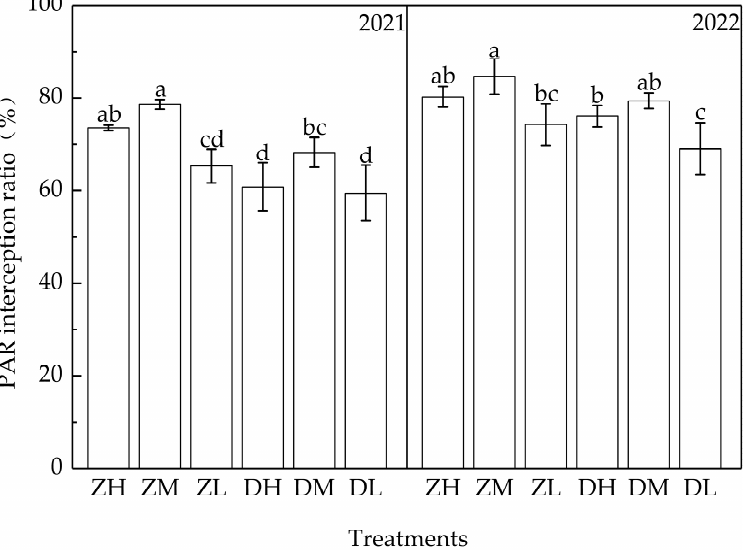
Figure 3. Effects of plant densities and genotypes on the PAR interception ratio at the middle of canopy at R2 (filling stage) in 2021 and 2022. Z represents Zhengdan 958, D represents Denghai 605; H represents high density, M represents middle density, and L represents low density. Vertical bars represent standard errors. Bars labeled at the top of the column with different letters are significantly ( p < 0.05) different among treatments using LSD post hoc test.